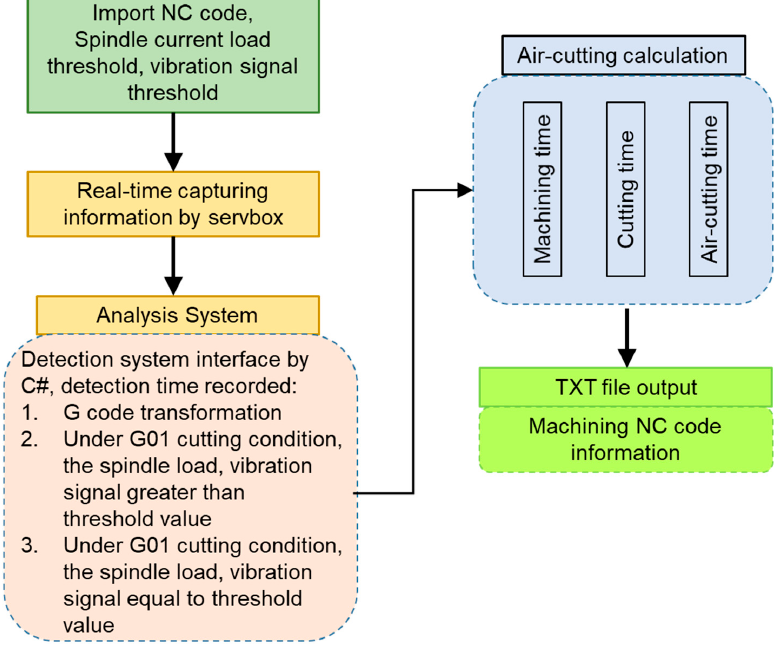
Figure 1. The architecture of the air cutting monitoring system. Generally, the G code command for the cutting process is G01, G02, and G03. Another G00 code is mainly used for rapid moving position, and the time for this movement is called air cutting time. To better differentiate air cutting under individual cutting com- mands, the NC code is identified by using the regular expression method. When the ma- chining condition is under one of three cutting NC codes, the judgment is performed to determine the entry of the cutting status and the current time of the computer is recorded. The spindle load is displayed on the control panel with the letter “L 0%”, which rep- resents the spindle load is 0%. For example, the spindle load current when idle is 0%, and this value is used as the initial value of the spindle load. When the spindle load current is greater than 0% during the machining process, it indicates that the cutting state and the current time are recorded. On the other hand, when the spindle load current changes back from the state of greater than 0% to 0%, it indicates the no-cutting state, and the current time is recorded for the subsequent processing time calculation usage. Since the original vibration signal fluctuates between positive and negative, it is dif- ficult to see the characteristics directly. Therefore, the root mean square (rms) of the vibra- tion signal is calculated and used to monitor the cutting vibration signals, so the cutting state can be differentiated clearly. After the rms processing, the machine idle rms vibration value is multiplied by the magnification and becomes greater than the maximum machine idle original vibration value to avoid system misjudgment. For example, if the machine idle original vibration value is in the range of 0.01 g to 0.02 g, the recommended magnifi- cation value is 2 or more. The air cutting diagnosis and time recording are as follows: